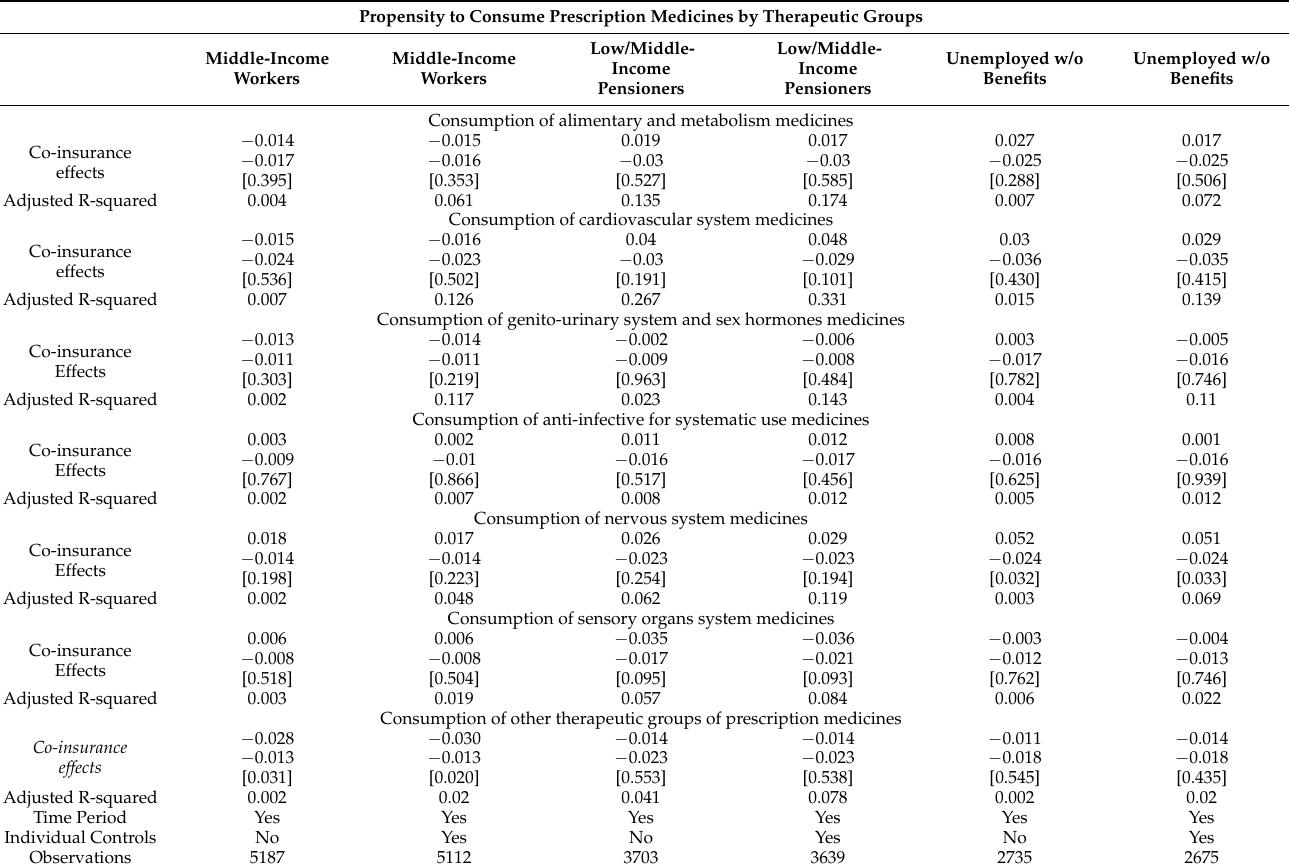
Table 7. Impact of the intervention on the propensity to consume prescription medicines according to therapeutic group. Propensity to Consume Prescription Medicines by Therapeutic Groups Low/Middle- Low/Middle- Middle-Income Middle-Income Unemployed w/o Unemployed w/o Income Income Workers Workers Benefits Benefits Pensioners Pensioners Consumption of alimentary and metabolism